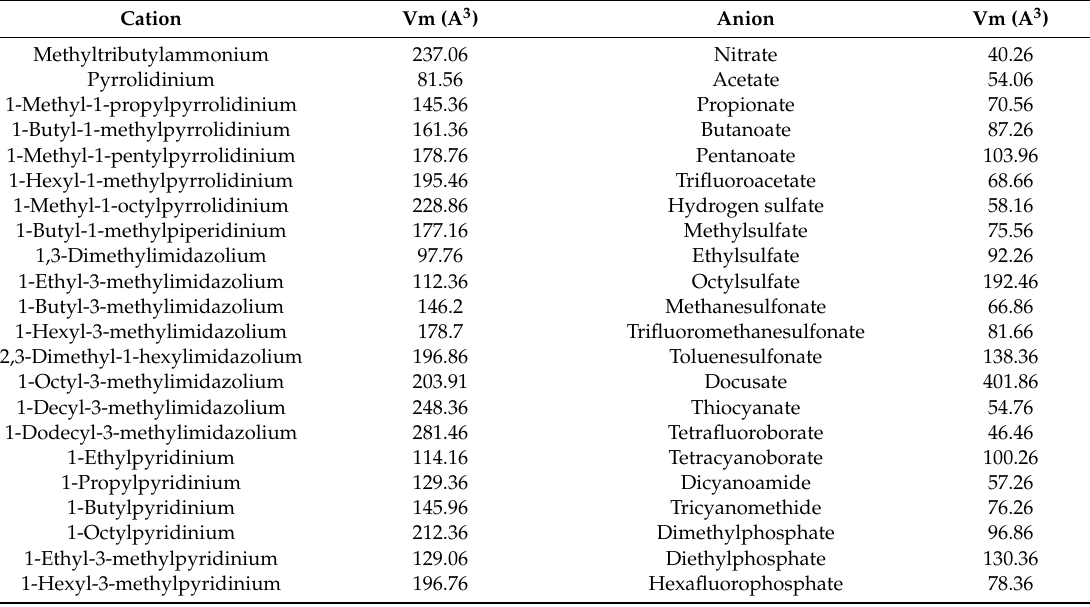
Table 2. Molecular volumes of popular cations and anions used in ionic liquids.